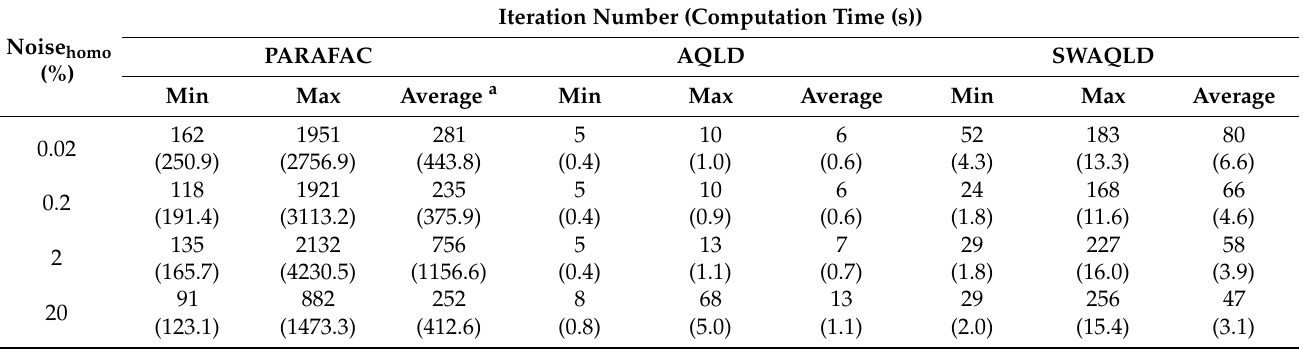
Table 3. The convergence property of PARAFAC, AQLD, and SWAQLD for simulated excitation– emission–kinetic four-way phosphorescence data with four levels of homoscedastic